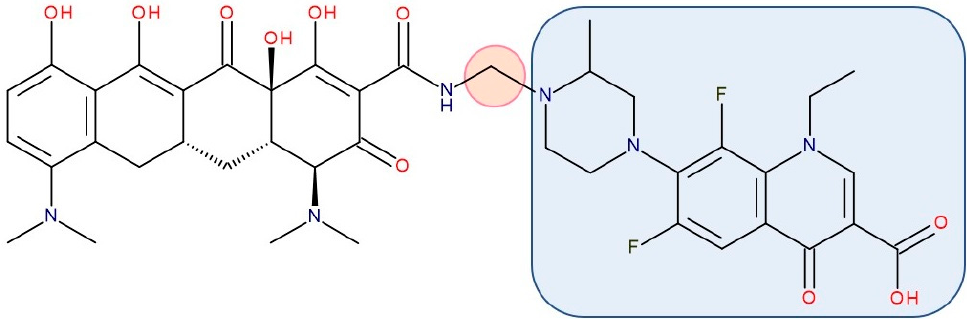
Figure 9. Antibiotic–antibiotic hybrid containing an FQN: minocycline–linker–lomefloxacin; the linker is highlighted with the orange circle while the QN/FQN unit is highlighted by the blue rectangle [267].